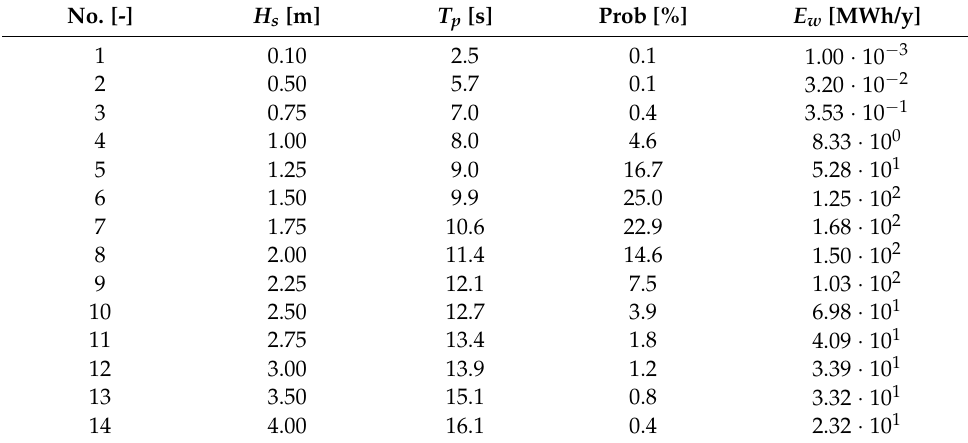
Table 4. Simulated sea states for the case-study